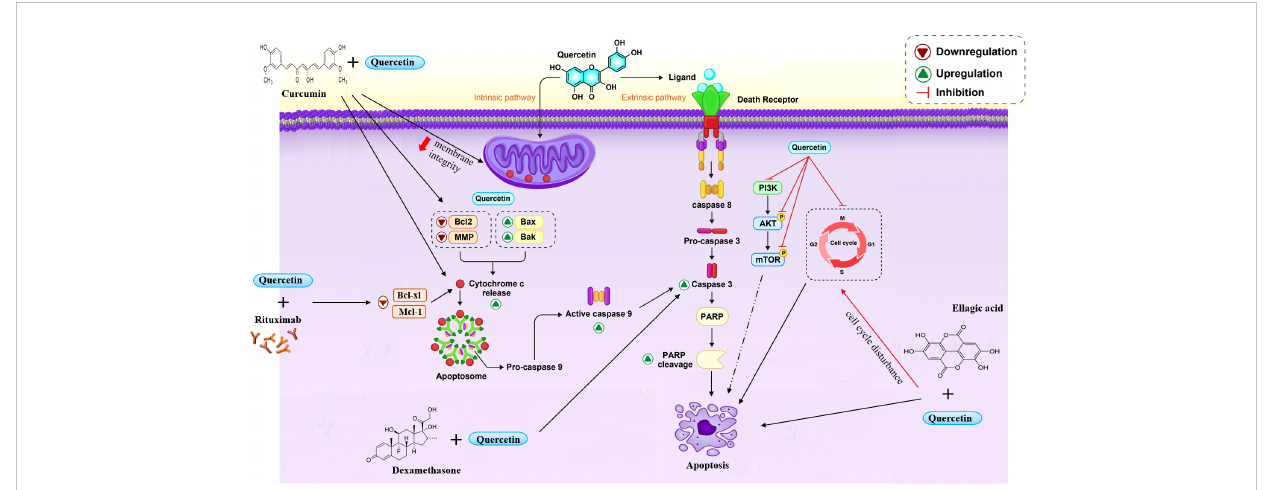
FIGURE 1 Quercetin induce cell apoptosis through different ways. Quercetin induced c-cytochrome-dependent apoptosis and caspase-3. Also quercetin suppressed cell cycle in different phases and inhibited the phosphorylation of PI3K/Akt and mTOR. Co-treatment quercetin with some compounds improved the ef fi cacy and increased